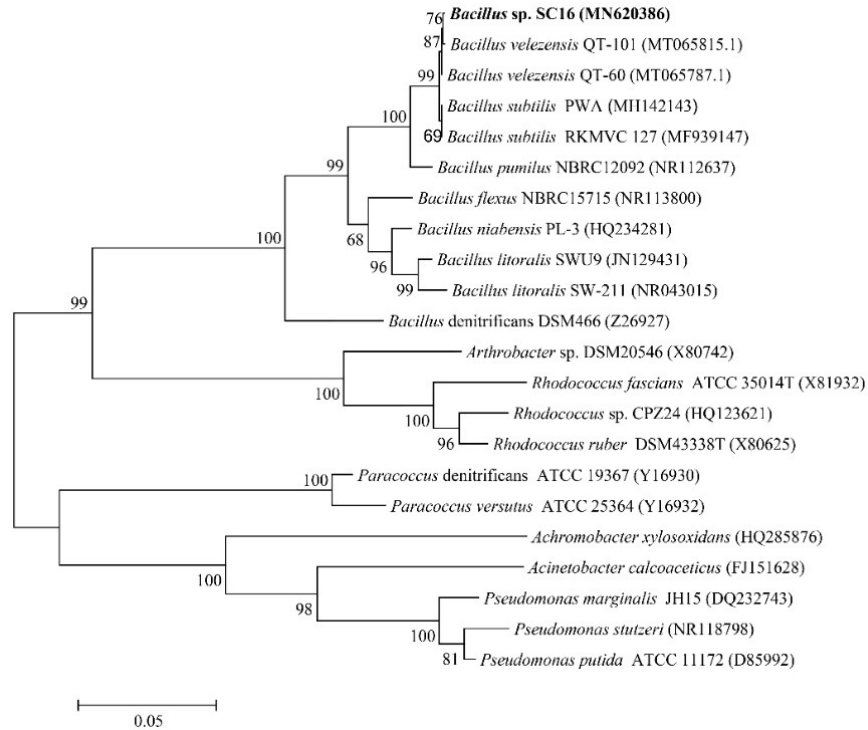
Figure 2. Phylogenetic tree of 16S rRNA of strain SC16 and other strains was constructed using the maximum-likelihood method. Bootstrap values were calculated by 1000 repetitions; 0.02 denotes the genetic distance. The accession numbers of the GenBank sequences are shown in parentheses.